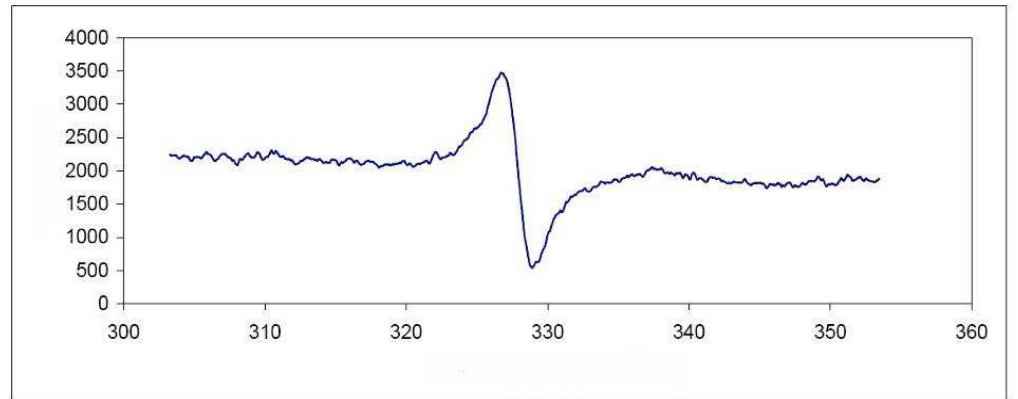
Figure 5. EPR spectrum of the reaction.